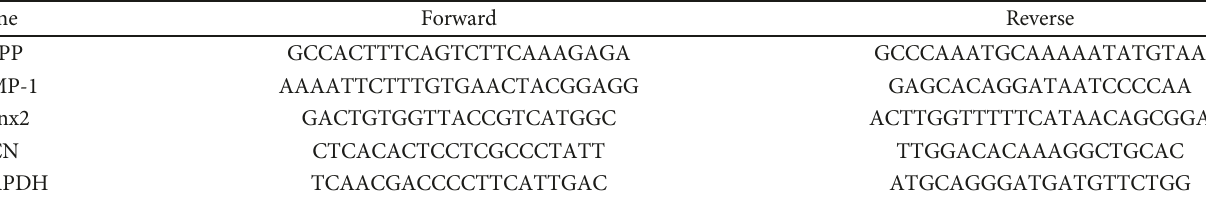
Table 1: The sequences of speci fi c primers for real-time PCR